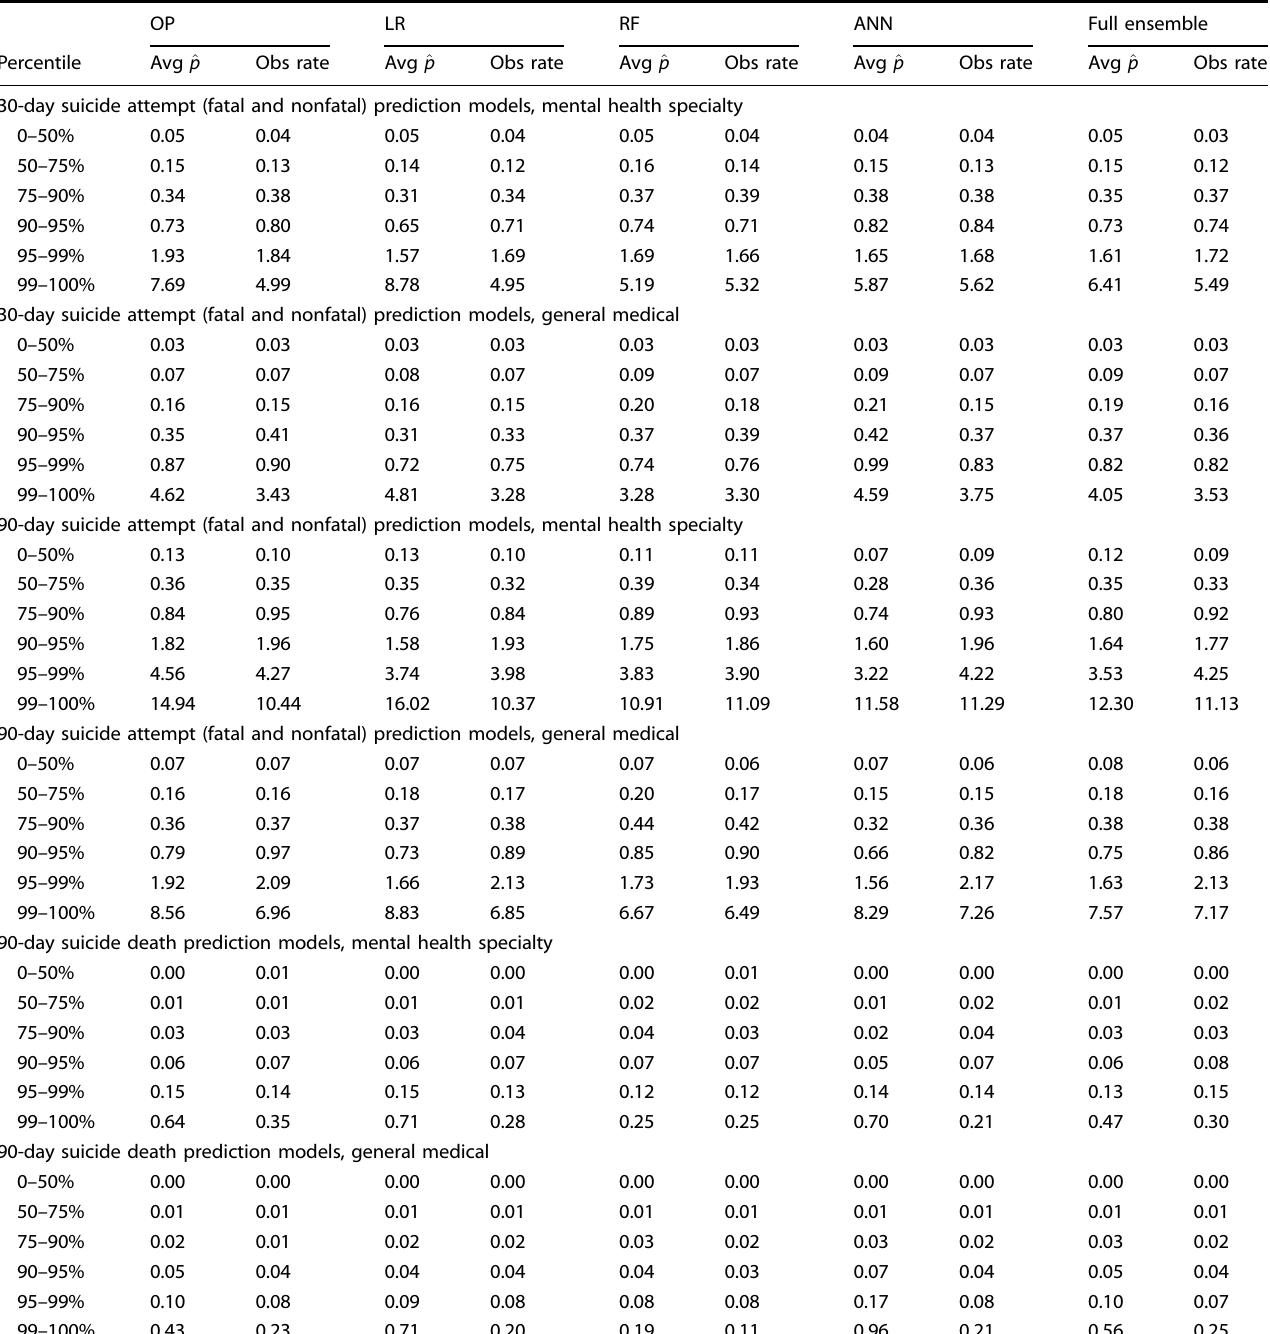
Table 4. Calibration tables for all models in mental health specialty and general medical samples with percentiles de fi ned on training dataset and applied to validation dataset.